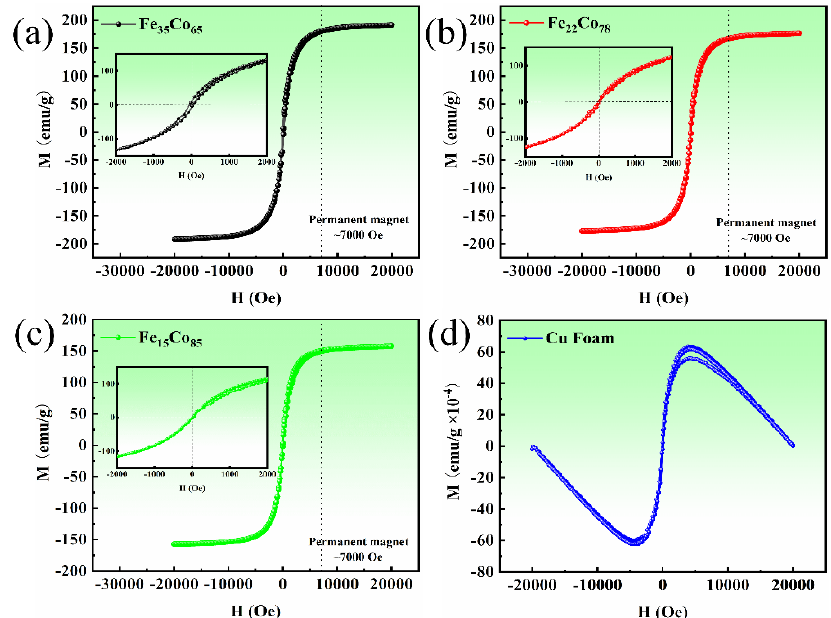
Figure 4. Hysteresis loop of Fe 35 Co 65 ( a ), Fe 22 Co 78 ( b ), Fe 15 Co 85 ( c ) and Cu foam ( d ) .